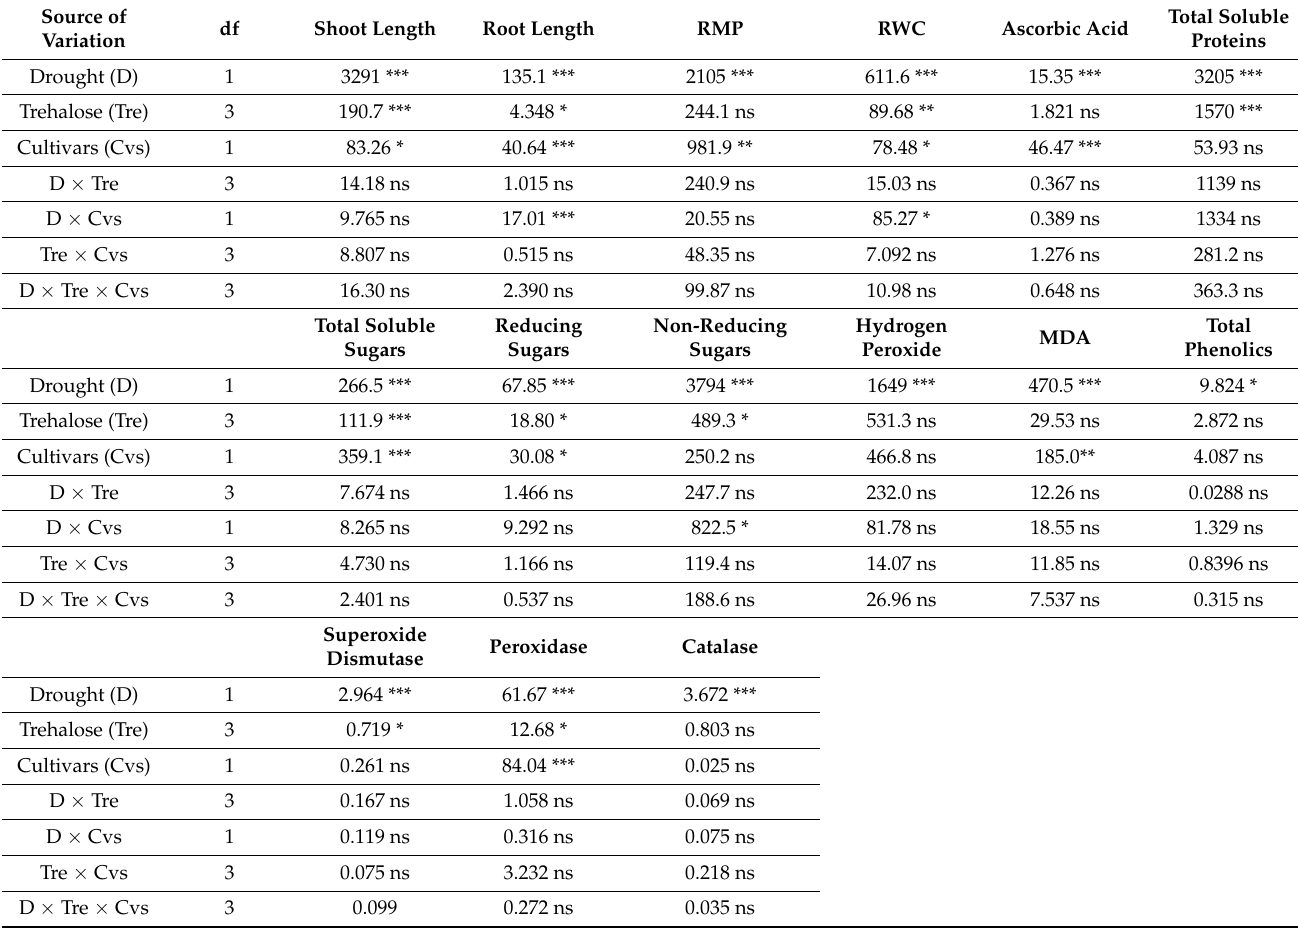
Table 1. Mean square data for different physio-biochemical attributes of sunflower ( Helianthus annuus ) plants subjected to varying (0, 10, 20, and 30 mM) levels of trehalose under drought